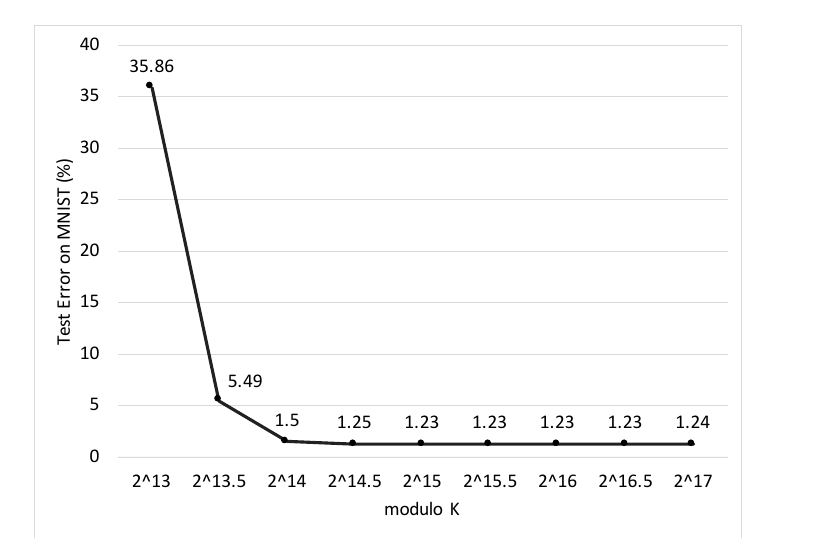
Figure 5: Error rate of MLP-MNIST vs value of modulo K used in the network. Each point represents one test configuration using the specified K in all layers (Decimal exponents are shown only for highlighting the error trend in software implementation, actual hardware implementation only uses integer